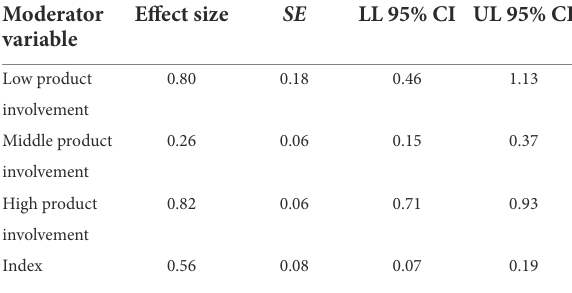
TABLE 8 Results for the effect of IEPEC on inconsistency brand attitude across levels of product